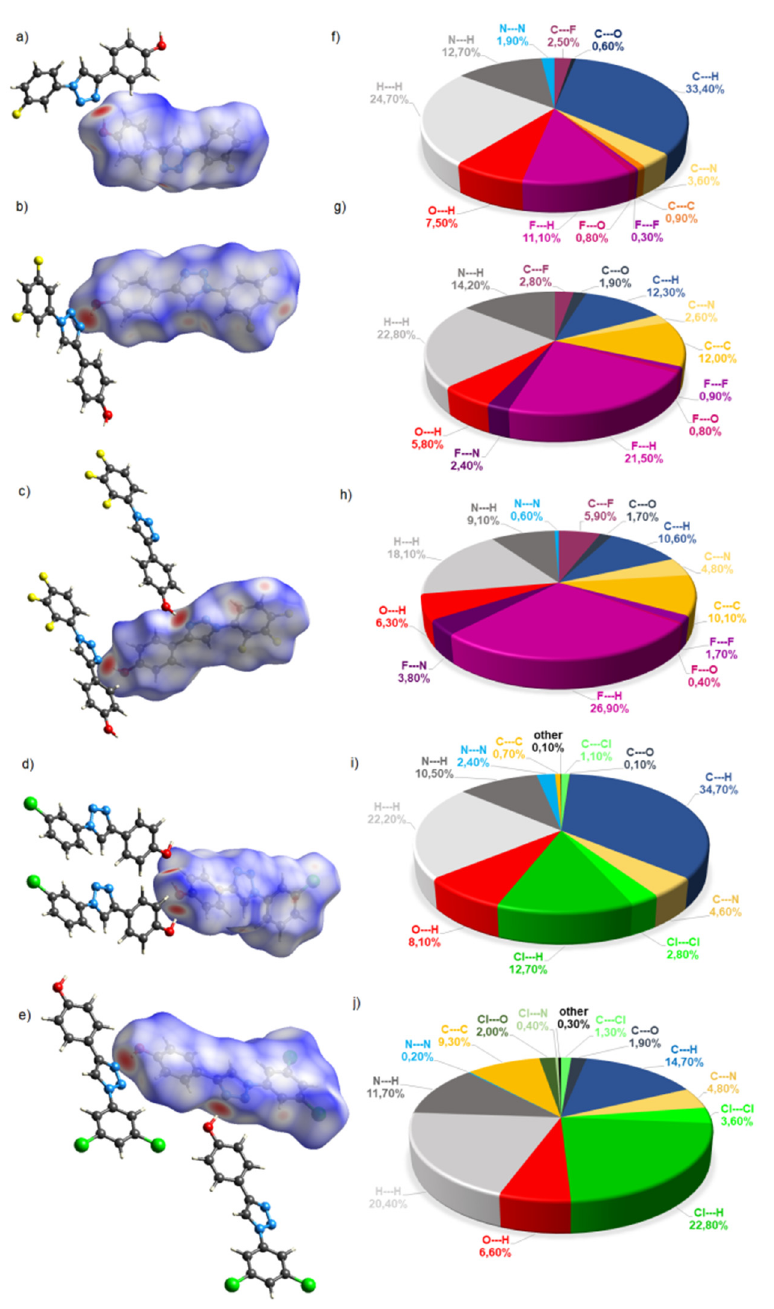
Figure 4. Hirshfeld surfaces of ( a ) 6a , ( b ) 6b , ( c ) 6c , ( d ) 6d , ( e ) 6e . Red color: normalized contact distances for 6a – e : d norm shorter than the sum of van der Waals radii (for 6a : d norm = − 0.6166; 6b : d norm = − 0.5728; 6c : d norm = − 0.5901; 6d : d norm = − 0.3820; 6e : d norm = − 0.6177), white color: van der Waals contacts (for 6a : d norm = 0.4140; 6b : d norm = 0.3931; 6c : d norm = 0.3738; 6d : d norm = 0.3266; 6e : d norm = 0.4040), blue color: normalized contact distances exceeding the sum of van der Waals radii (for 6a : d norm = 1.3683; 6b : d norm = 1.2271; 6c : d norm = 1.1824; 6d : d norm = 1.0046; 6e : d norm = 1.1712); ( f – j ), Hirshfeld surface fingerprint decompositions showing main types of interactions for compounds 6a – e .